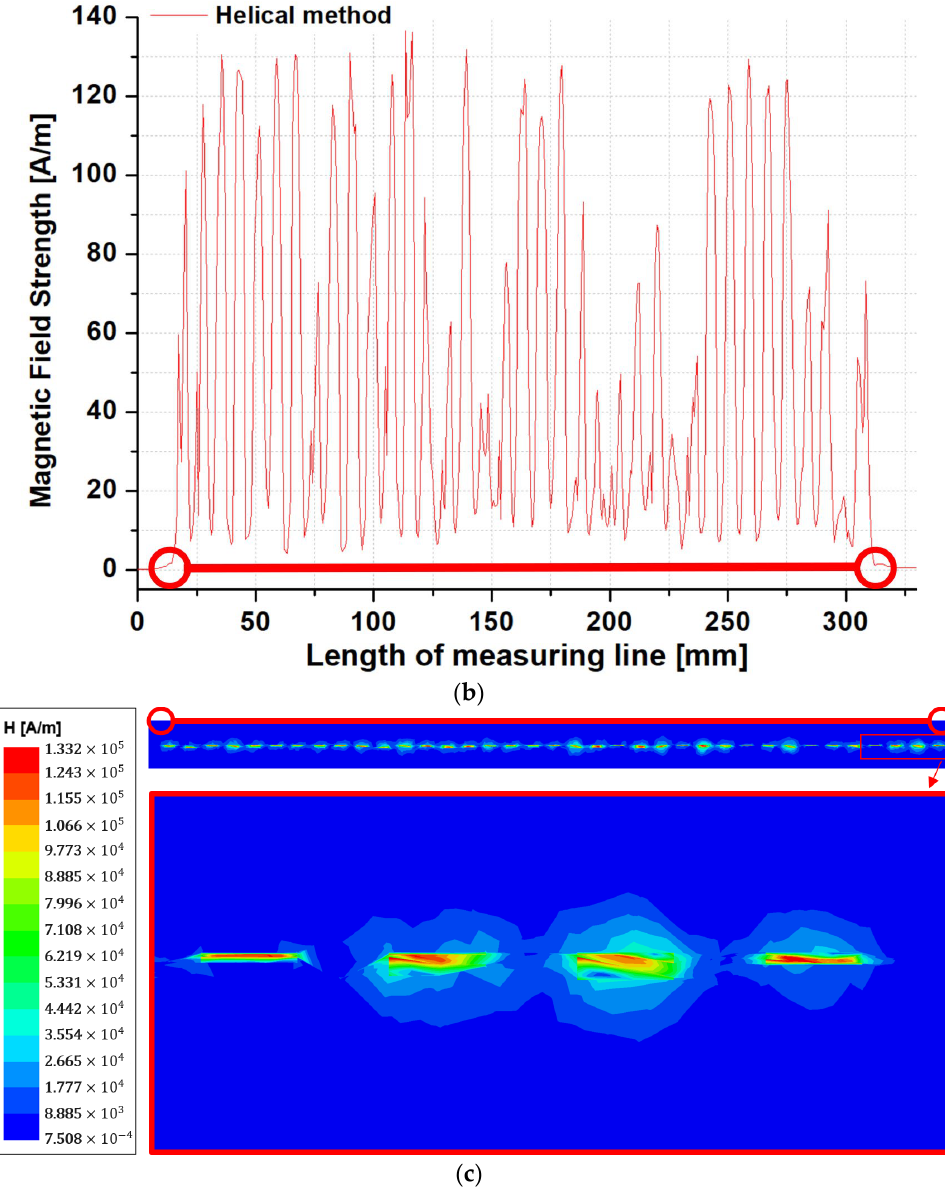
Figure 12. Magnetic field distribution diagram of bifilar-helical type: ( a ) the magnetic field distribution, ( b ) the strength of the magnetic field, ( c ) the distribution map of the magnetic field generated from some superconducting wires.